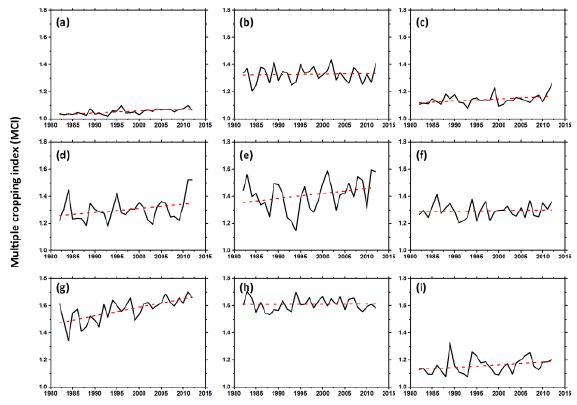
Figure 5. Spatial distribution of multiple cropping system in selected years from 1982 to 2012. (a)-(d) indicate the spatial distribution of MCI in 1982, 1992, 2002 and 2012 with a 10- year interval, respectively. The green represents the spatial distribution of single cropping system, the orange represents that of the twice cropping system, and the dark red represents that of the triple cropping system. The insets show the global percentage of different cropping systems.